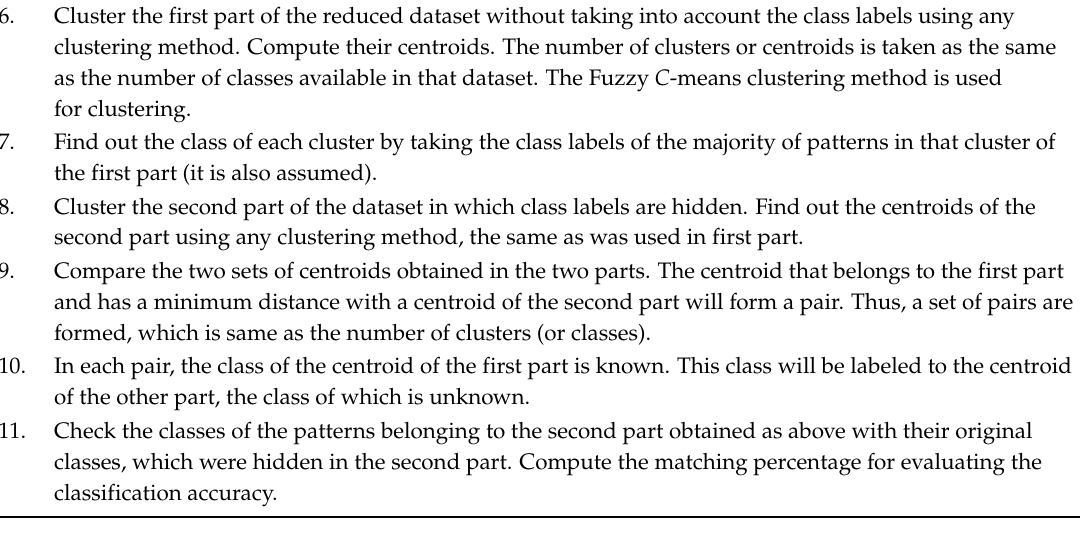
Table 2. The number of patterns with known and unknown labels in the dataset.